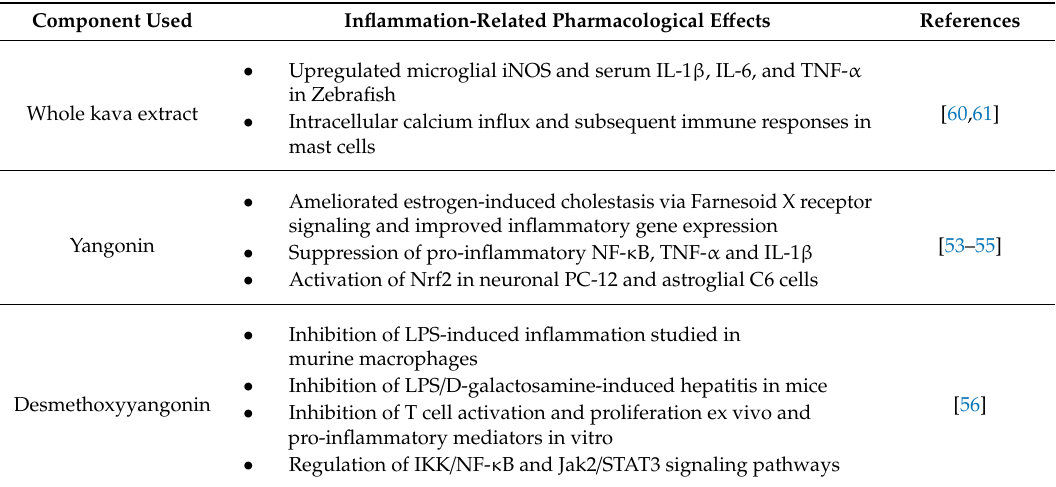
Table 3. Summary of inflammation-related e ff ects and